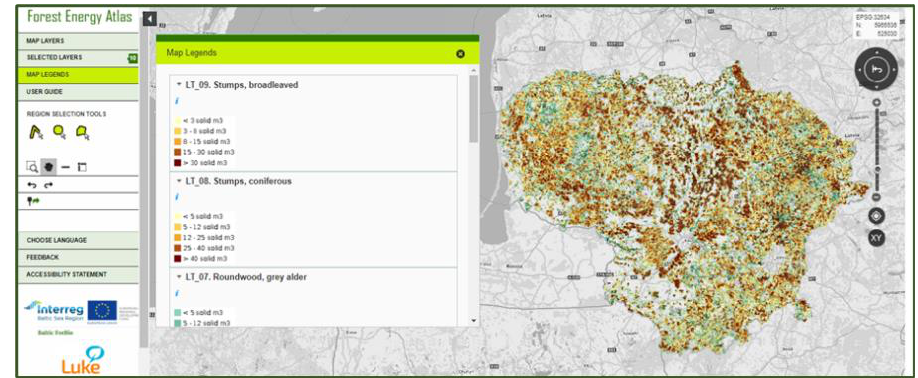
Figure 18. Forest Energy Atlas (presenting data for Lithuania). Source: [76].